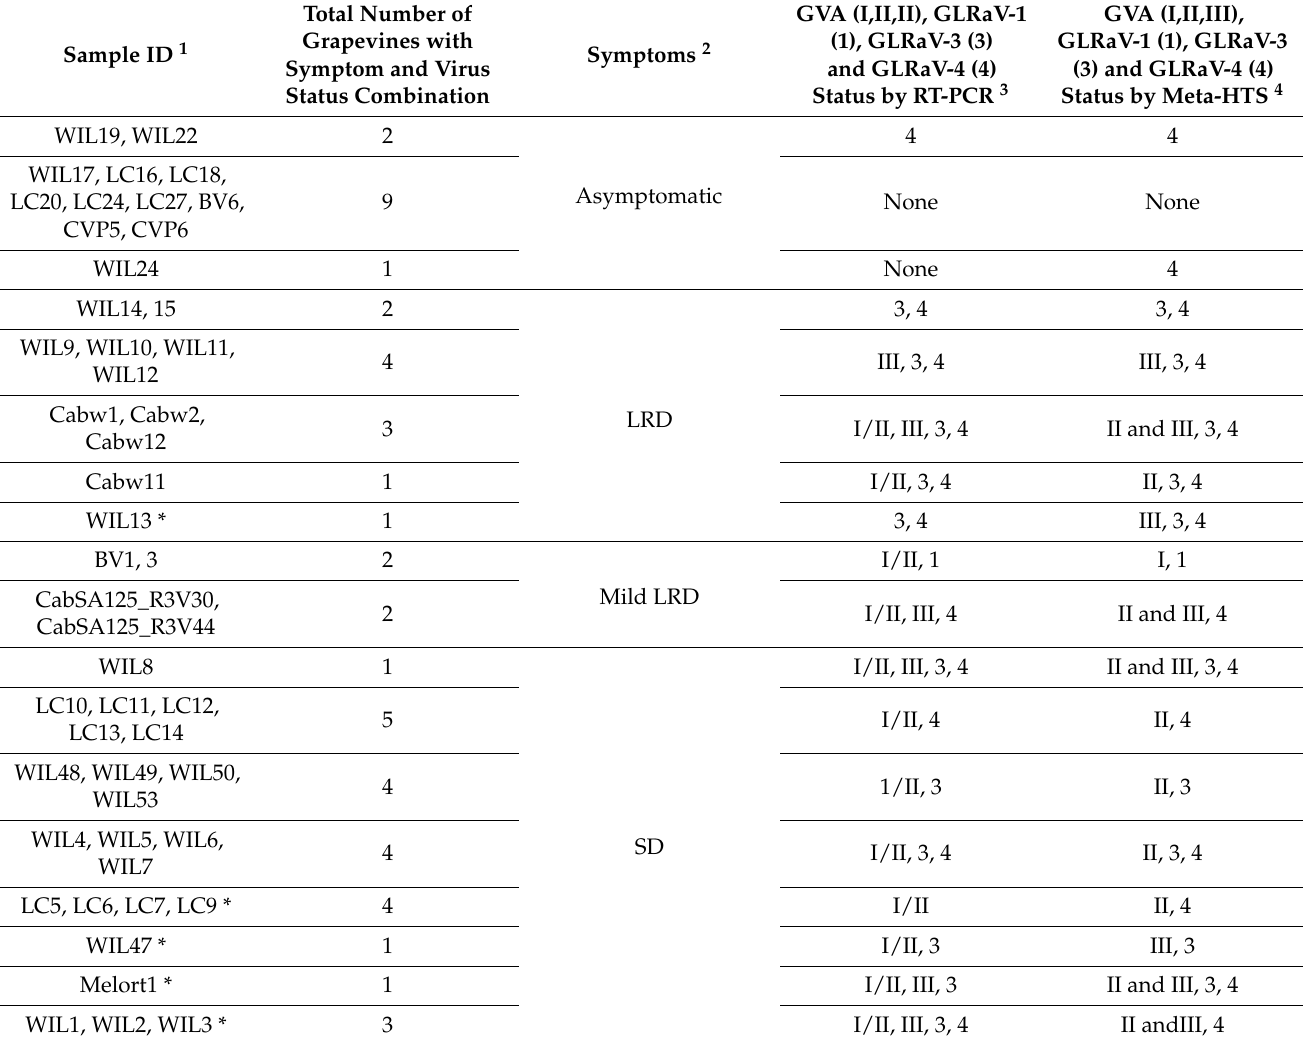
Table 2. The presence of grapevine virus A (GVA), and grapevine leafroll-associated viruses 3 (GLRaV-3) and -4 (GLRaV-4) determined by endpoint RT-PCR and metagenomic high-throughput sequencing (Meta-HTS), and associated symptoms, in 50